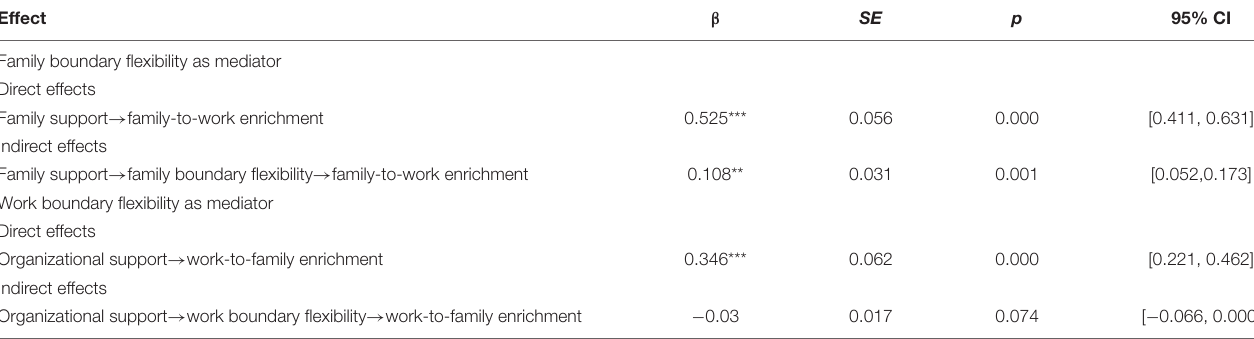
FIGURE 2 | Influence of family support on FWE: family boundary flexibility as the intermediary. TABLE 3 | Direct and indirect effects of family and organizational support on work-family